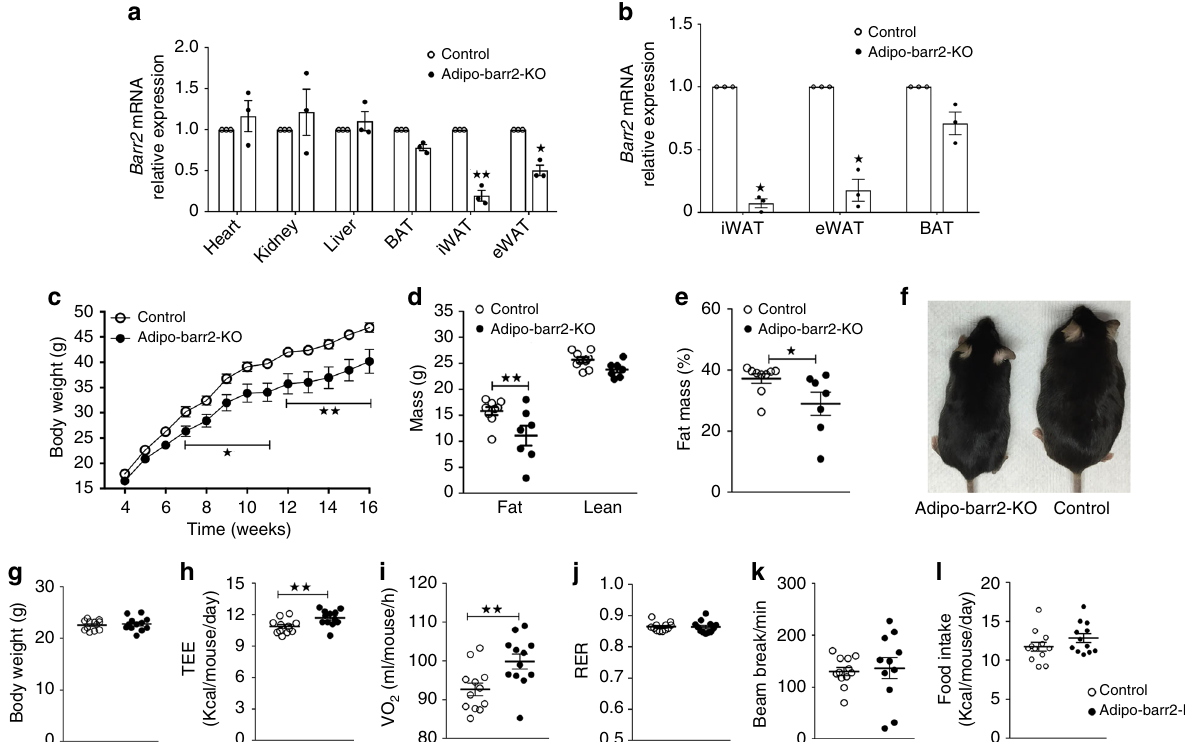
Fig. 1 Mice lacking barr2 in adipocytes show decreased body weight and fat mass, and increased energy expenditure when maintained on a HFD. a Expression of barr2 mRNA in different tissues of adipo-Cre barr2 f/f mice and control littermates ( barr2 f/f ). Barr2 expression data are normalized relative to the expression of β -actin ( n = 3 per group). For simplicity, we refer to the adipo-Cre barr2 f/f mice as adipo-barr2-KO mice throughout the manuscript. b Relative mRNA expression levels of barr2 in isolated mature adipocytes from iWAT, eWAT, and BAT ( n = 3 or 4 per group). c Body weights of control and adipo-barr2-KO mice consuming a HFD ( n = 7 – 9 per group). d , e Body composition ( d ) and fat mass (% of body weight) ( e ) of mice maintained on a HFD for 12 weeks ( n = 7 – 9 per group). f Images of representative control and adipo-barr2-KO KO mice (12-week-old males on HFD). g – k Metabolic studies during the initial phase of HFD feeding ( fi rst week; mouse age: 6 – 7 weeks). g Body weight. h Total energy expenditure (TEE). i Oxygen consumption